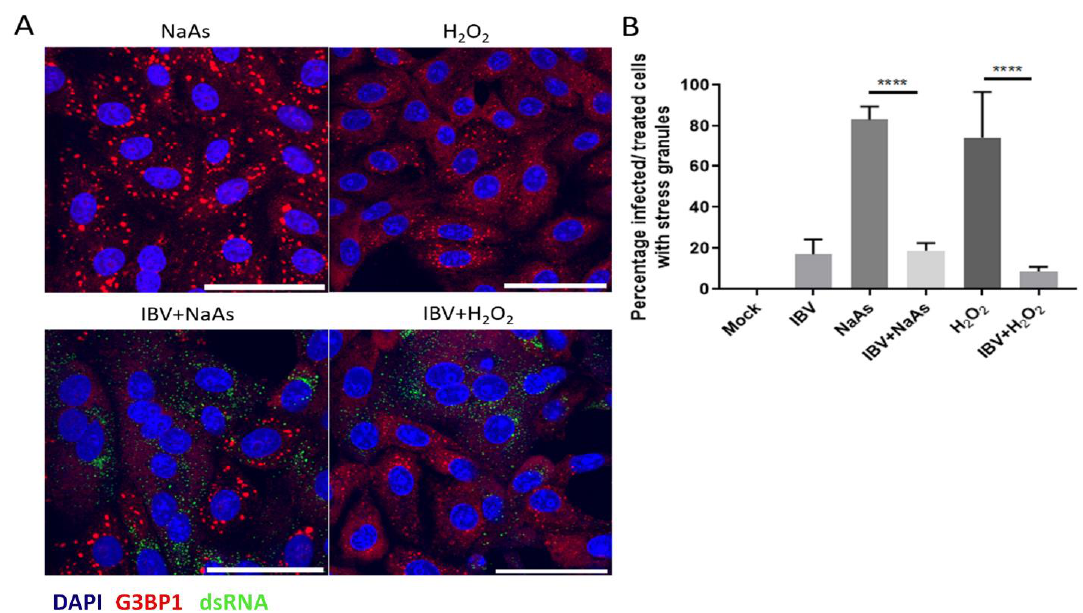
Figure 2. IBV inhibits eIF2 α -dependent and independent stress granule induction. ( A ) Vero cells were mock infected or infected with IBV for 24 hours. Prior to fixation, cells were treated for 1 hour with 500 µ M sodium arsenite (NaAs) to activate the eIF2 α -dependent pathway or for 2 h with 2 µ M hydrogen peroxide (H 2 O 2 ) to activate the eIF2 α -independent pathway. At 24 hpi, cells were fixed and stress granules (SG) were labelled with an anti-G3BP1 antibody (red). IBV infection was detected with an anti-dsRNA antibody (green). Nuclei were stained with DAPI (blue) and scale bar indicates 50 µ m. ( B ) Images from ( A ) were quantified by manual counting of SG positive cells, identified by counting infected or treated cells with G3BP1 foci. A minimum of 50 cells were counted. Data from three independent replicates. Asterisks indicate statistical significance as measured by one-way ANOVA, **** p < 0.0001.